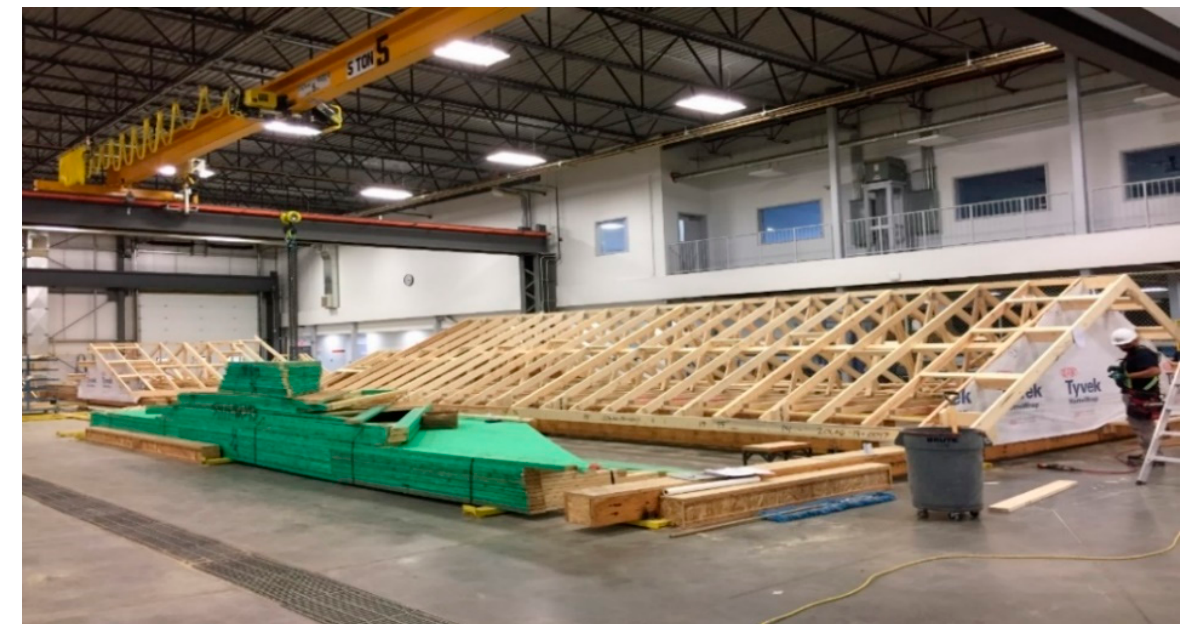
Figure 2. A roof production line (courtesy of ACQBUILT, Inc., Edmonton, AB, Canada) [2].